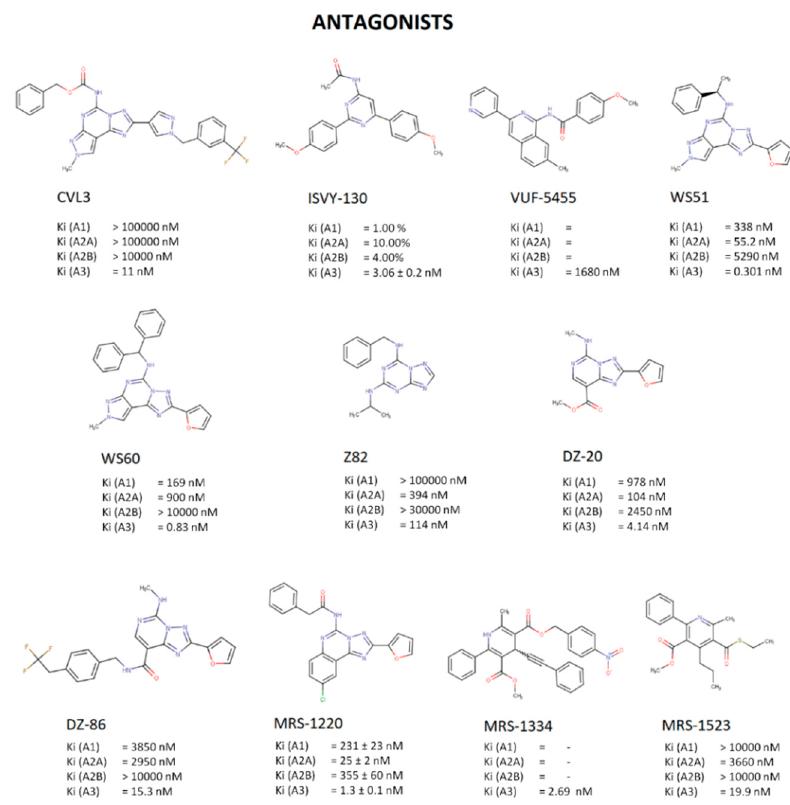
Figure 3. Chemical structures of antagonists selected for docking studies. Experimental Ki values (in nM or activity assay percentages) for each receptor subtype are also reported for comparison.